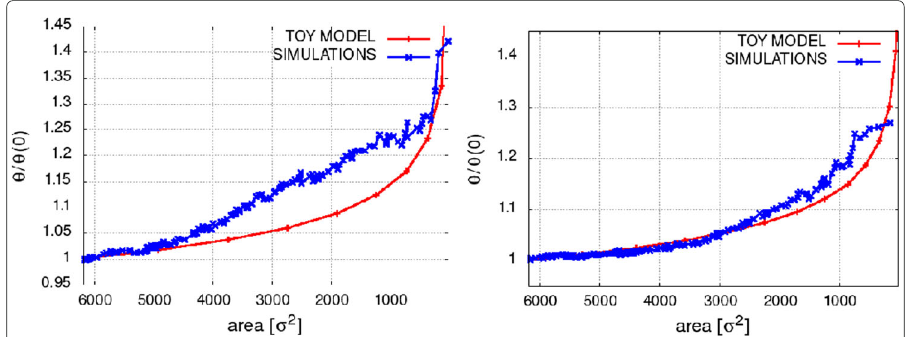
Fig. 11 Evolution of the misorientation θ as a function of the grain size predicted by the toy model (in red) compared with the results obtained by atomistic simulations (in blue) for θ 0 = 10 ◦ (left) and for θ 0 = 15 ◦